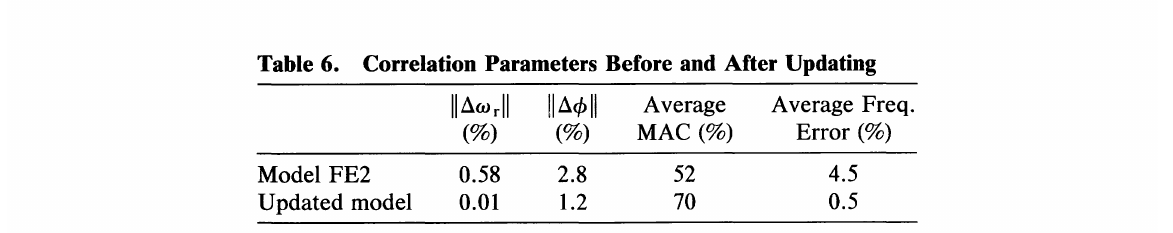
Table 6. Correlation Parameters Before and After